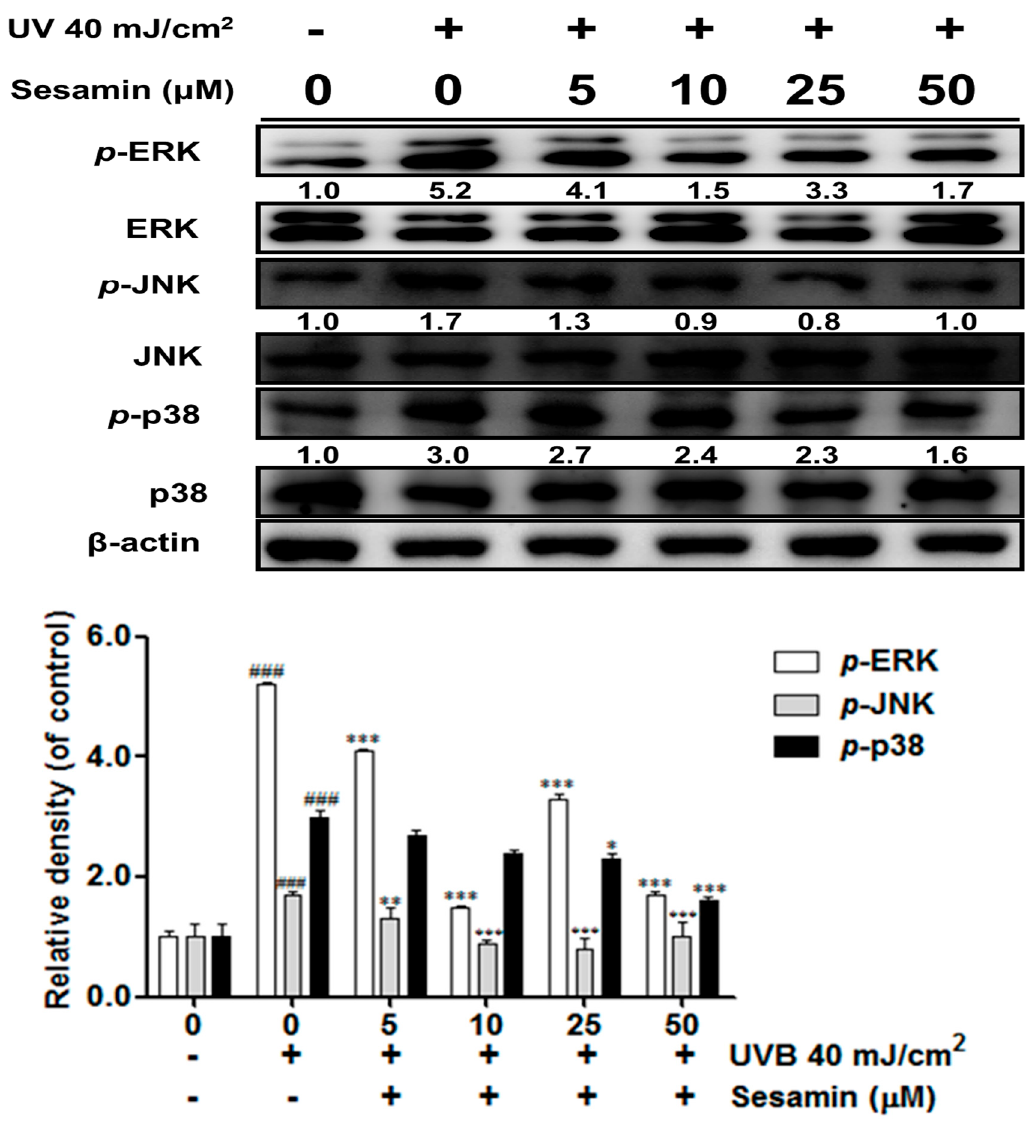
Figure 6. Sesamin inhibited on the UVB induced phosphorylation of mitogen-activated protein (MAP) kinases in human skin fibroblasts. ###, p < 0.001: Significant difference versus non-irradiation group. * p < 0.05; ** p < 0.01; *** p < 0.001: Significant difference versus non-treatment group. JNK: c-Jun N-terminal kinases.